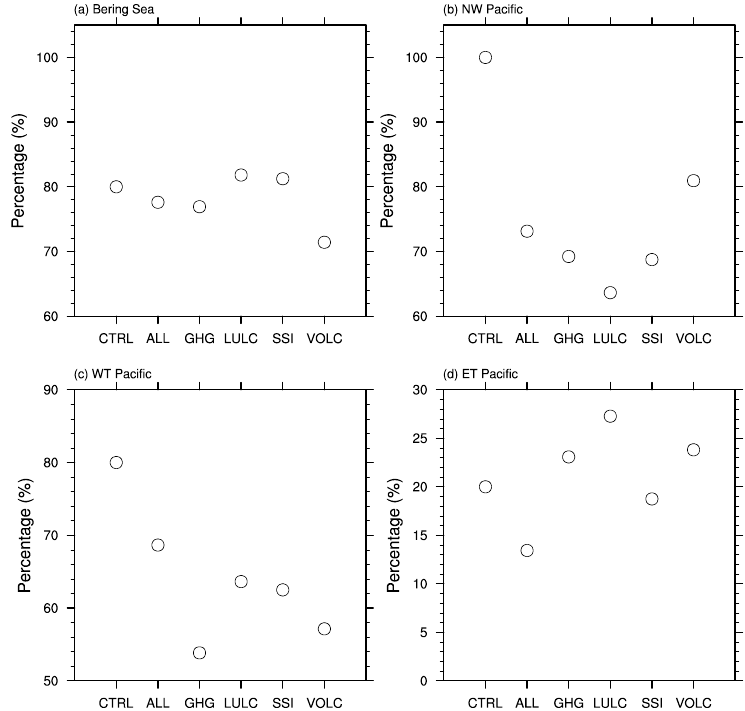
Figure 9. The percentages (unit: %) of megadroughts with sea surface temperature (SST) anomalies over the Bering Sea ( a ), NW Pacific ( b ), WT Pacific ( c ), and ET Pacific ( d ) significantly persisting throughout the entire drought period relative to the total megadrought events. For clarity, the ranges of y-axes are different.